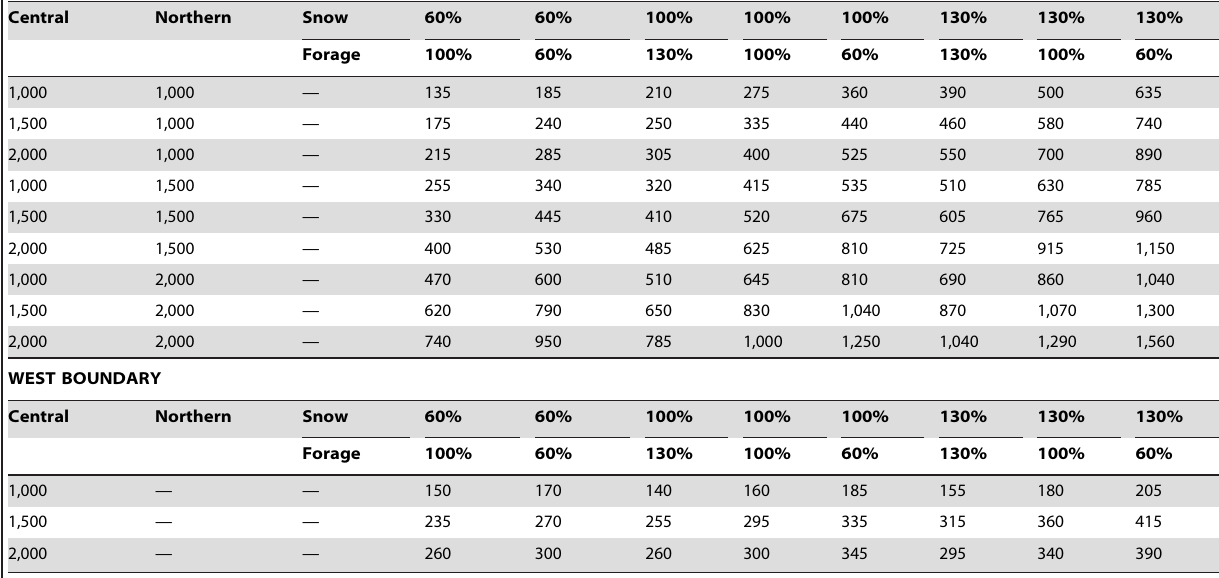
Table 2. Predicted annual maxima of bison migrating beyond the northern and western boundaries of Yellowstone National Park generated using a modified logistic process equation that incorporates the effects of central herd and northern herd size, accumulated SWE, aboveground dried biomass, and an interaction between herd size and accumulated SWE.